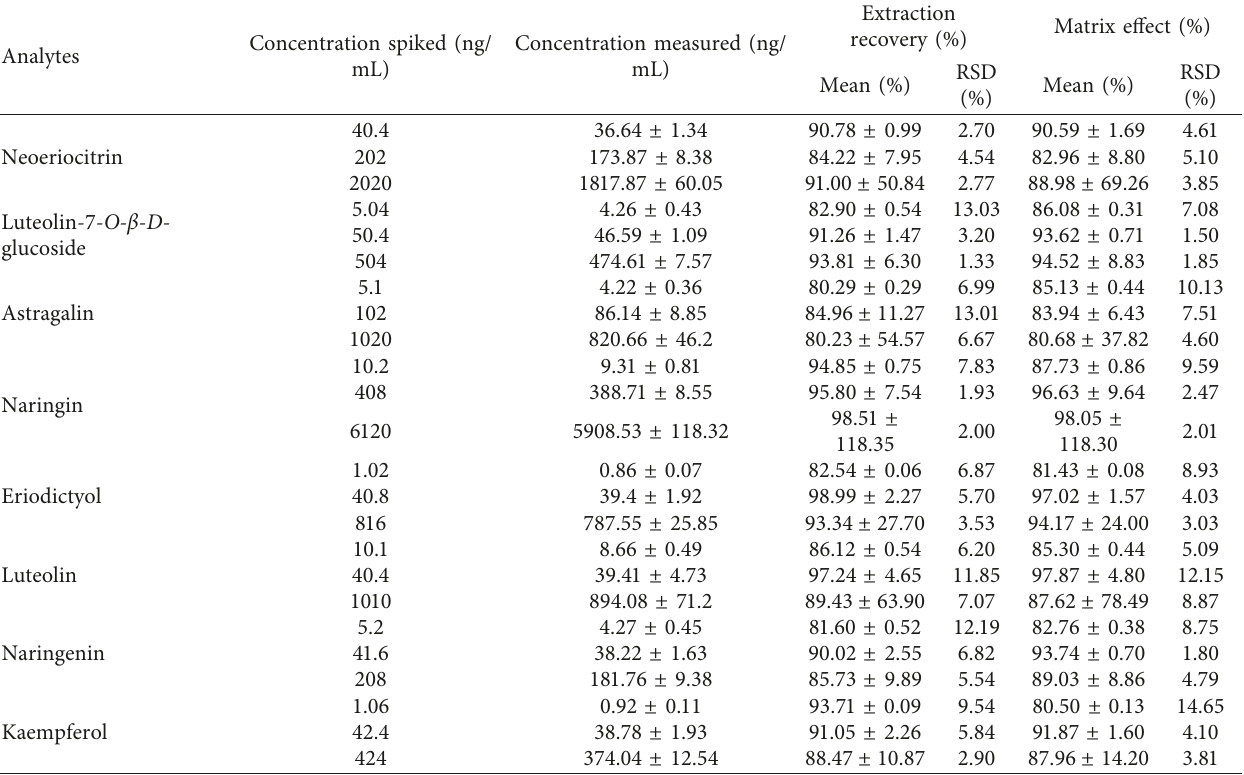
Table 4: Extraction recovery and matrix effect of eight analytes (mean ± SD, n � 6).